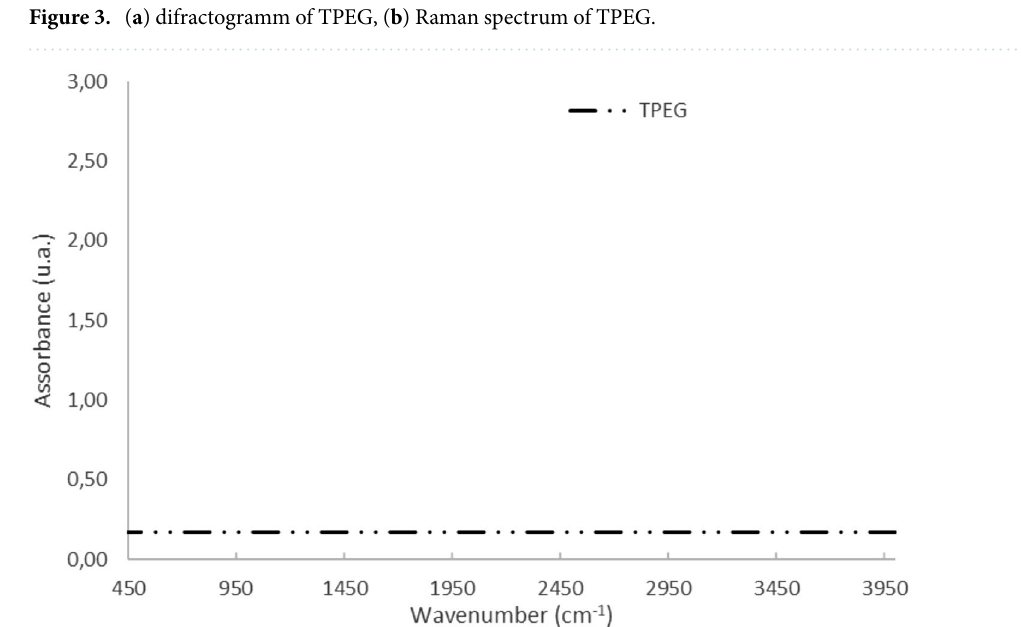
Figure 4. FT-IR spectrum acquired in the range 400–4000 cm −1 and resolution of 16 cm −1 .